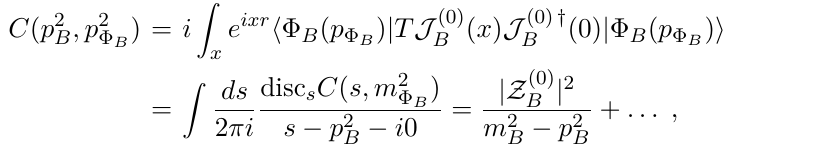
| 2 (3.9), where three B